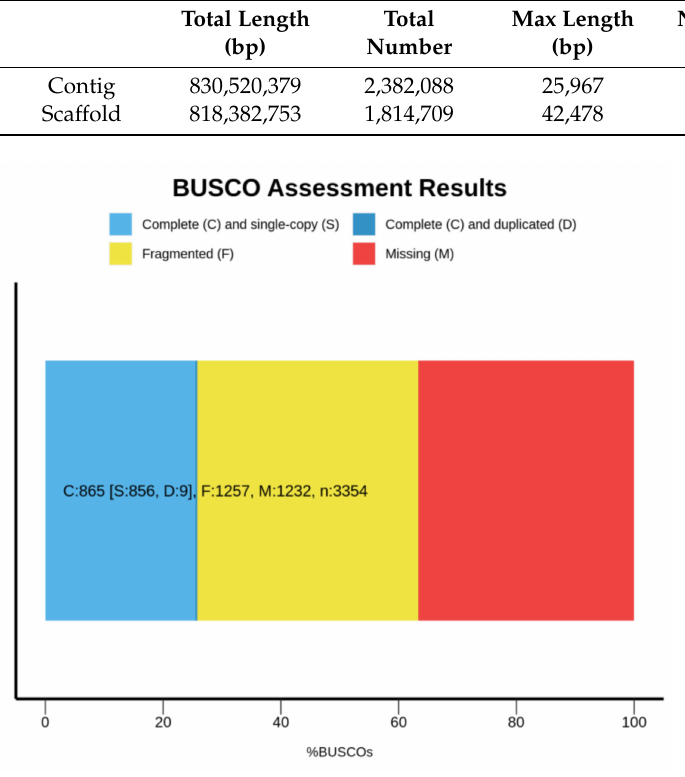
Figure 3. Assembly evaluation summary by